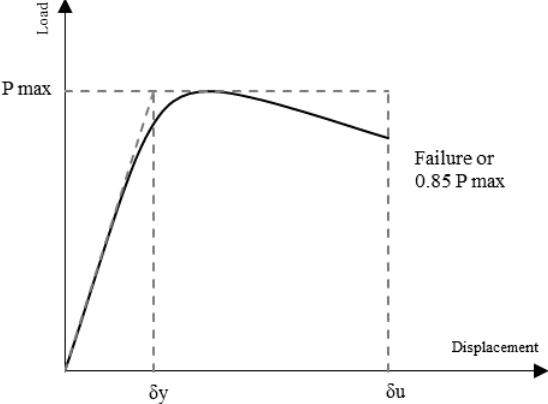
Figure 6. Determination of yield and ultimate displacements of columns, adapted from ref. [36].